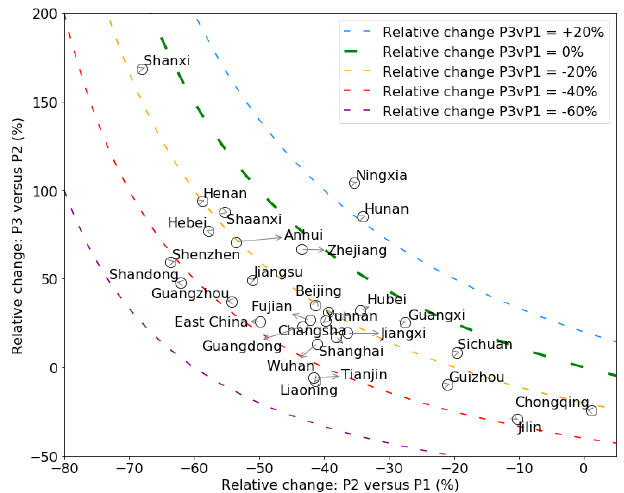
Figure 3. Relative changes between the three periods of individual modeled region, represented by the annotated circles. Colored contours represent the relative changes between top-down emissions during P3 vs these during P1.